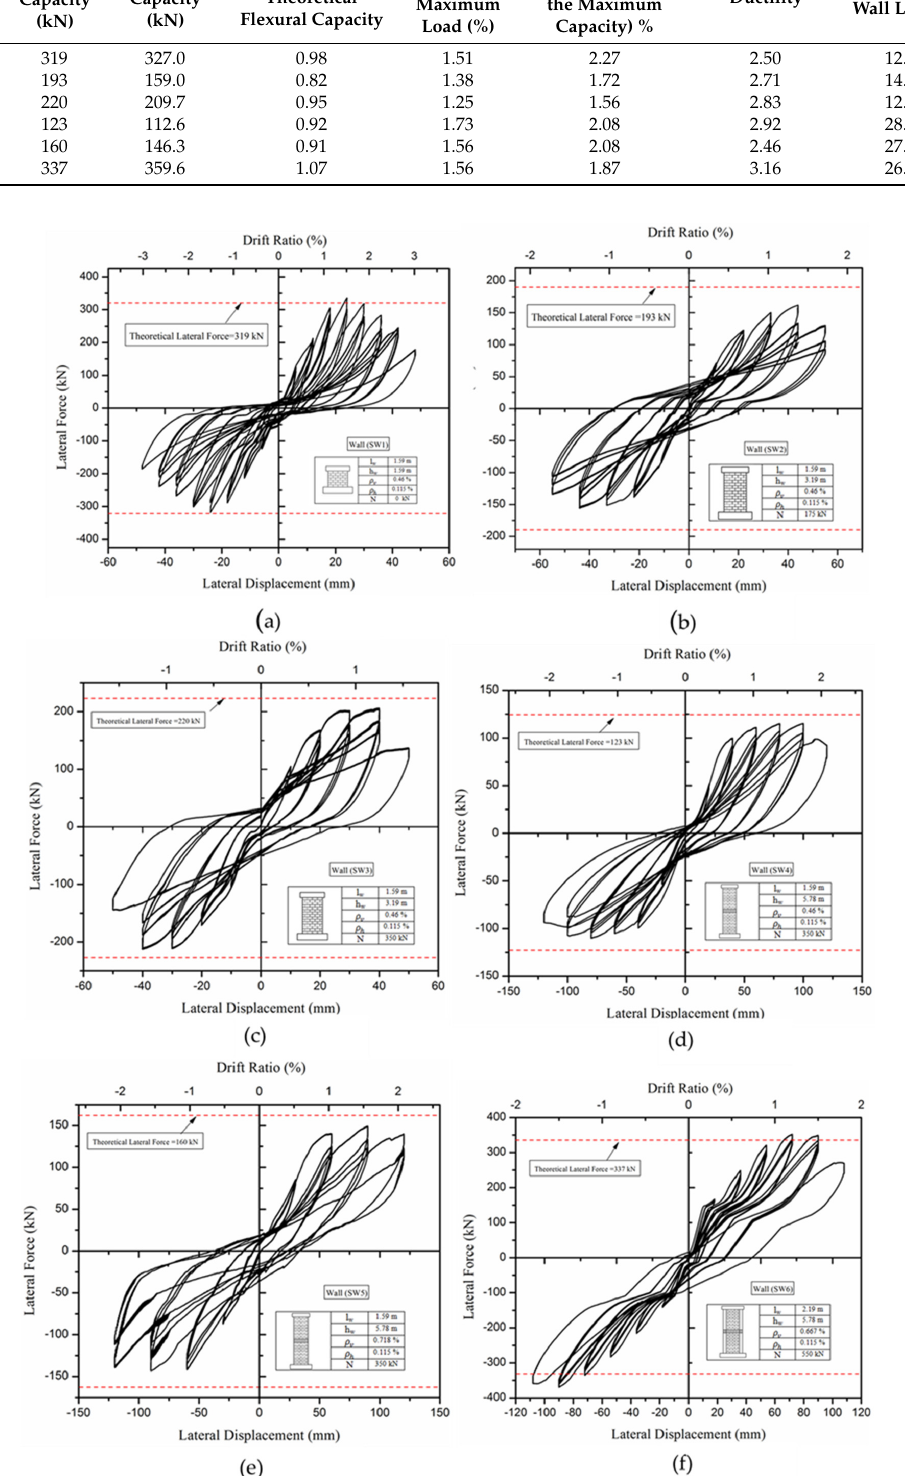
Figure 8. Load-displacement hysteresis diagrams for SCMSW specimens: ( a ) SW1; ( b ) SW2; ( c ) SW3; ( d ) SW4; ( e ) SW5; and ( f ) SW6.